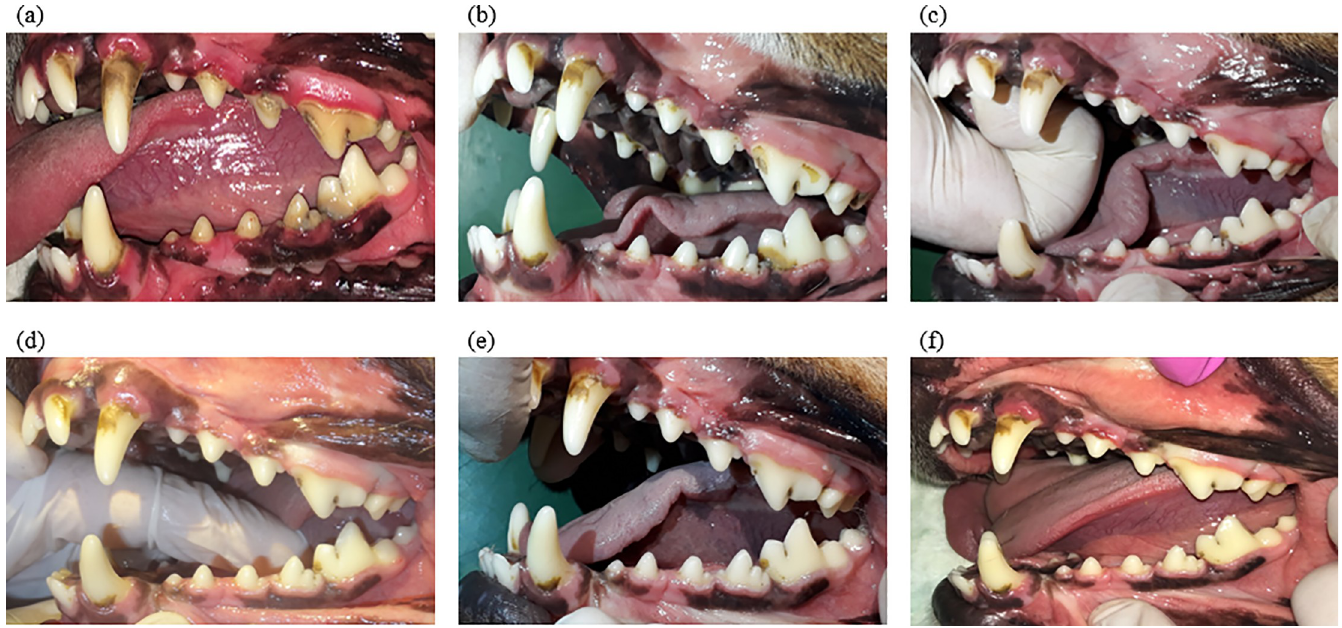
Fig 3. Left dental arcade of the same dog at days 0, 3, 6, 9, 12, and 14 (a–f, respectively) after daily supplementation of autoclaved spongy